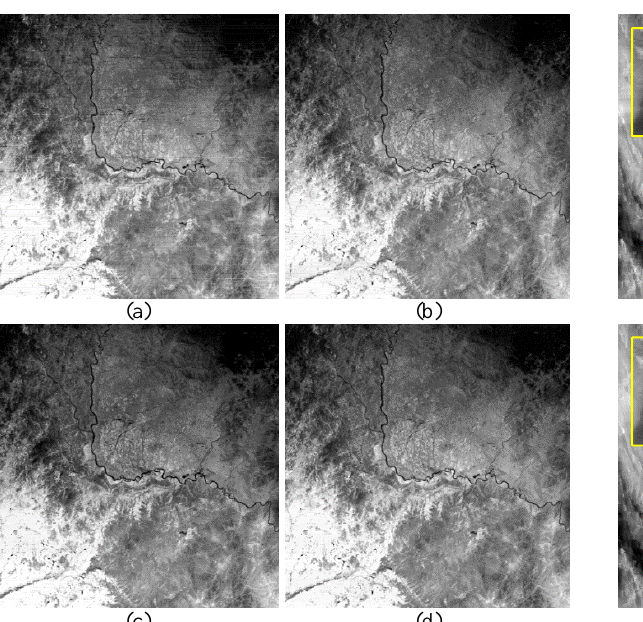
Fig 5. Destriping results of Terra MODIS band 9: (a)